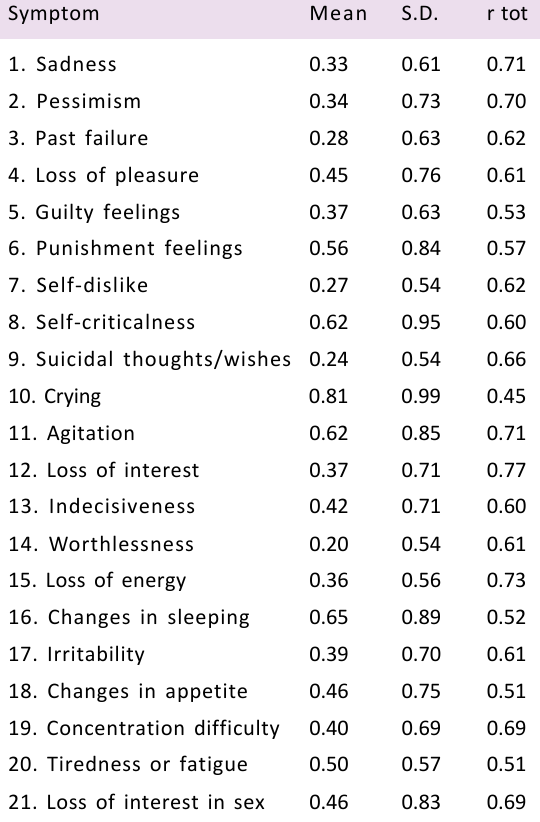
Table 1. Means, standard deviations and corrected item-total correlations of BDI II